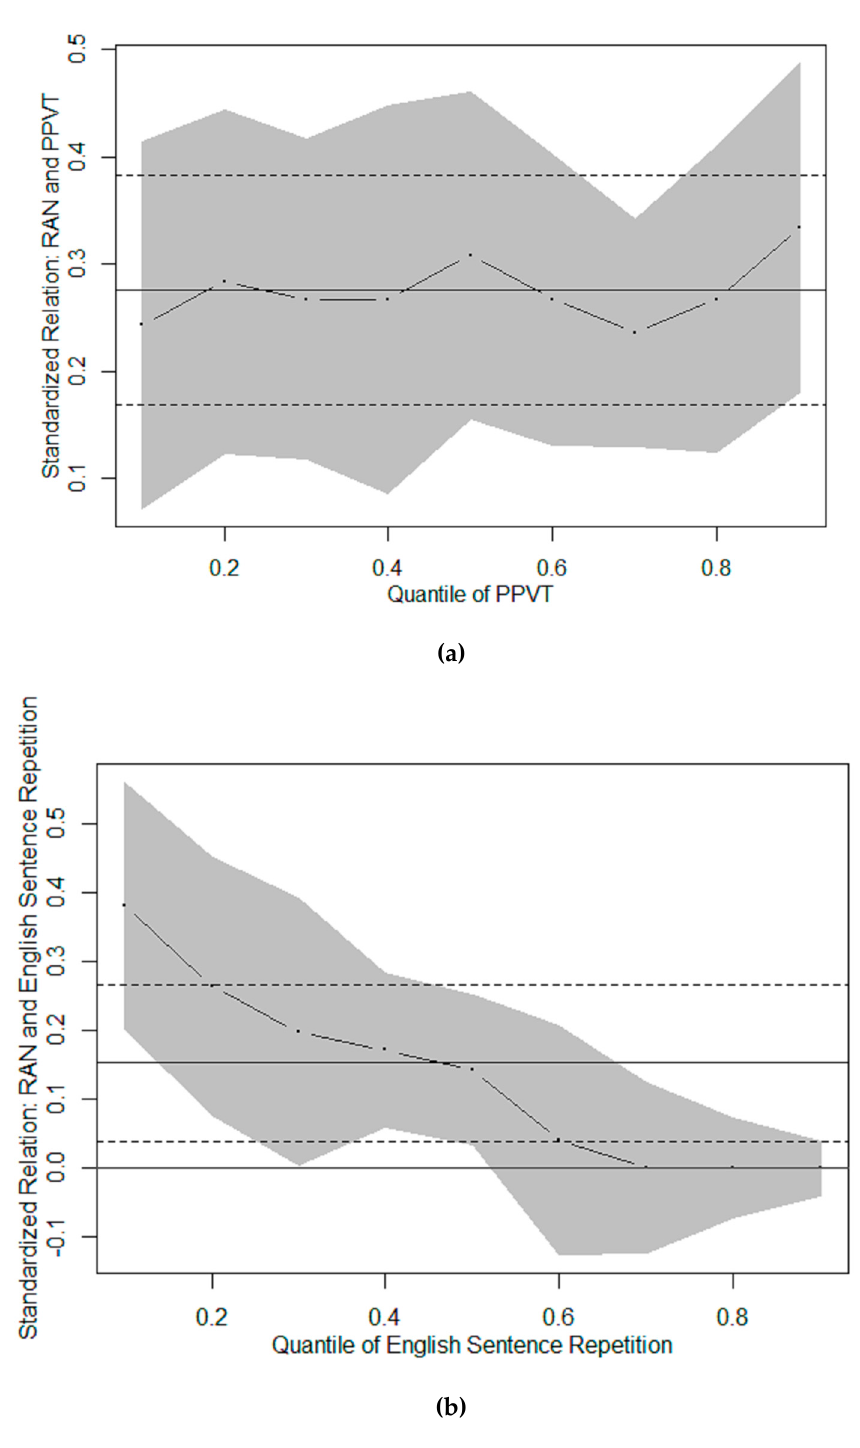
Figure 1. Quantile regression results for the relation between Rapid Automatic Naming (RAN) and Peabody Picture Vocabulary Test ‐ Fourth (PPVT) (a) and English Sentence Repetition (b) .